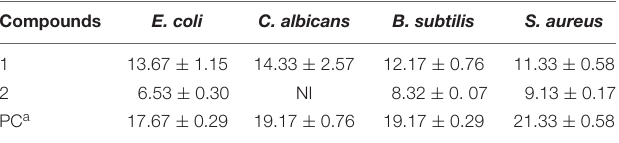
TABLE 3 | Antimicrobial activities of compounds isolated from BYCDW4 and BYCDW8 against the test pathogens (mm).